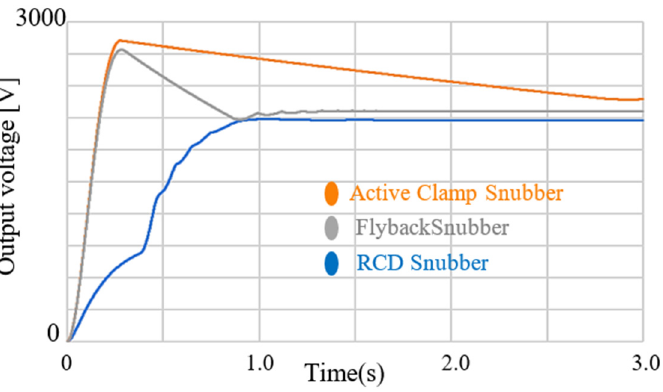
Figure 12. Output voltage of bidirectional converter, using three different snubber circuits.